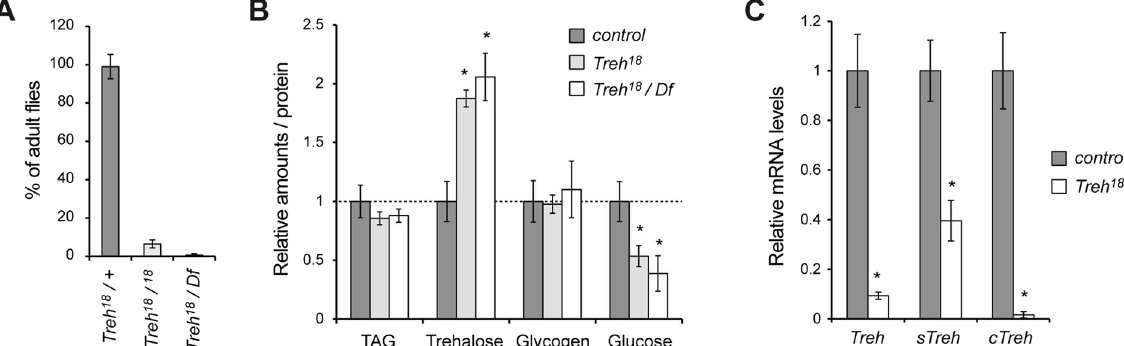
Figure 2. Treh 18 is a hypomorphic allele of Treh . ( A ) Backcrossed Treh 18 mutants exhibit pupal lethality with few escapers. The percentage of adult flies was determined by the ratio to flies with a balancer chromosome in each vial. Values shown are means and SEM. n = 6. ( B ) Treh 18 mutants increase trehalose levels and decrease glucose levels in late third instar larvae. Each value was normalized by protein levels and further normalized according to the level in the control larvae. ( C ) Treh transcript levels were analyzed by qRT-PCR at the mid third instar stage. Values are means and SD. n = 3 ( B , C ). * p < 0.01; ( B ) one-way ANOVA with Dunnett’s post hoc test, ( C ) two-tailed Student’s t